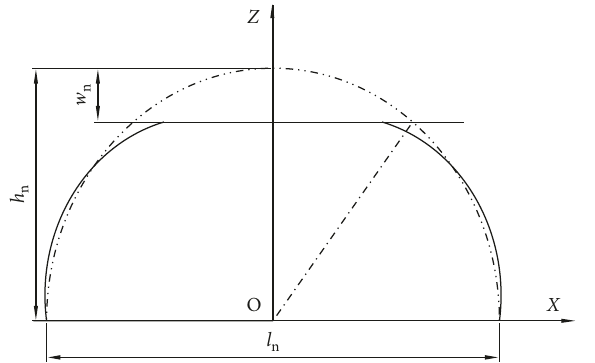
Figure 1: Diagram of single asperity